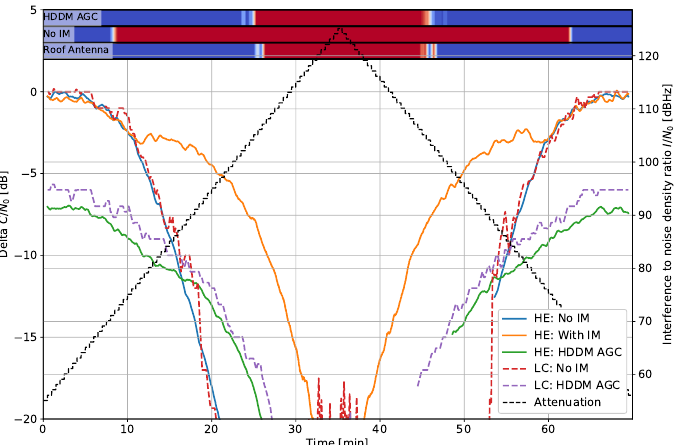
Figure 8. Interference #5: Delta C / N 0 for fast frequency hopper with 1 µs dwell time and 35 MHz